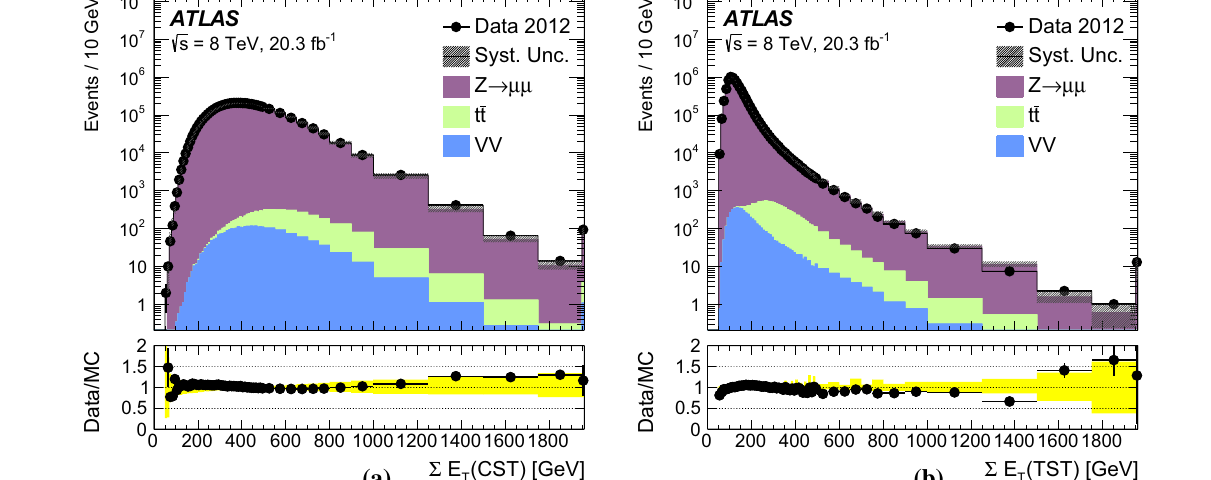
for distributions showing the are applied to the CST E miss T ). The intrinsic E miss CST E miss T T scale between data and a comparison of the E miss T